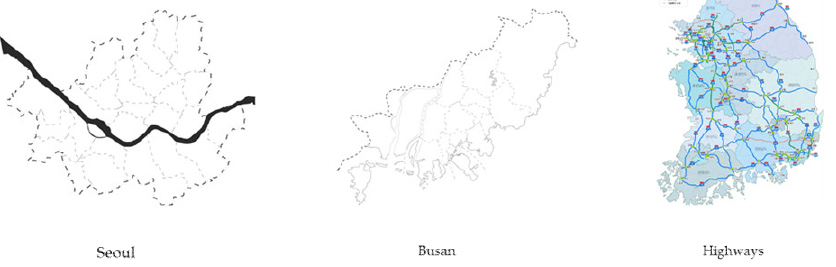
Figure 5. Dataset of urban road (Seoul and Busan) and inter-urban highways [39,40] (Copyright 2019 National Geographic Information Institute, Copyright 2014 Korea Expressway Corporation). Table 2. Number of annotations for each class in the